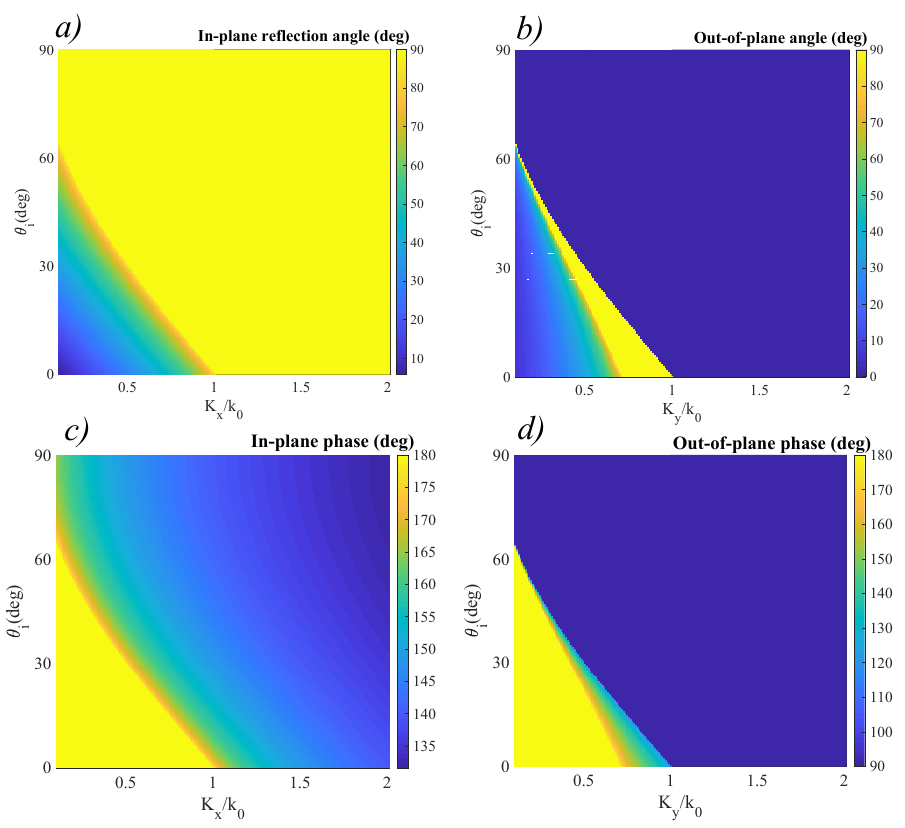
Figure 5. Reflection behavior of a linear-gradient optical interface. ( a ) In-plane reflection angle θ r obtained for a metasurface with a constant positive gradient K x across Ox . ( b ) The associated phase of the reflected in-plane wave. ( c ) Out-of plane reflection angle φ r for a metasurface with a constant positive gradient K y across Oy . ( d ) The associated phase of the out-of-plane